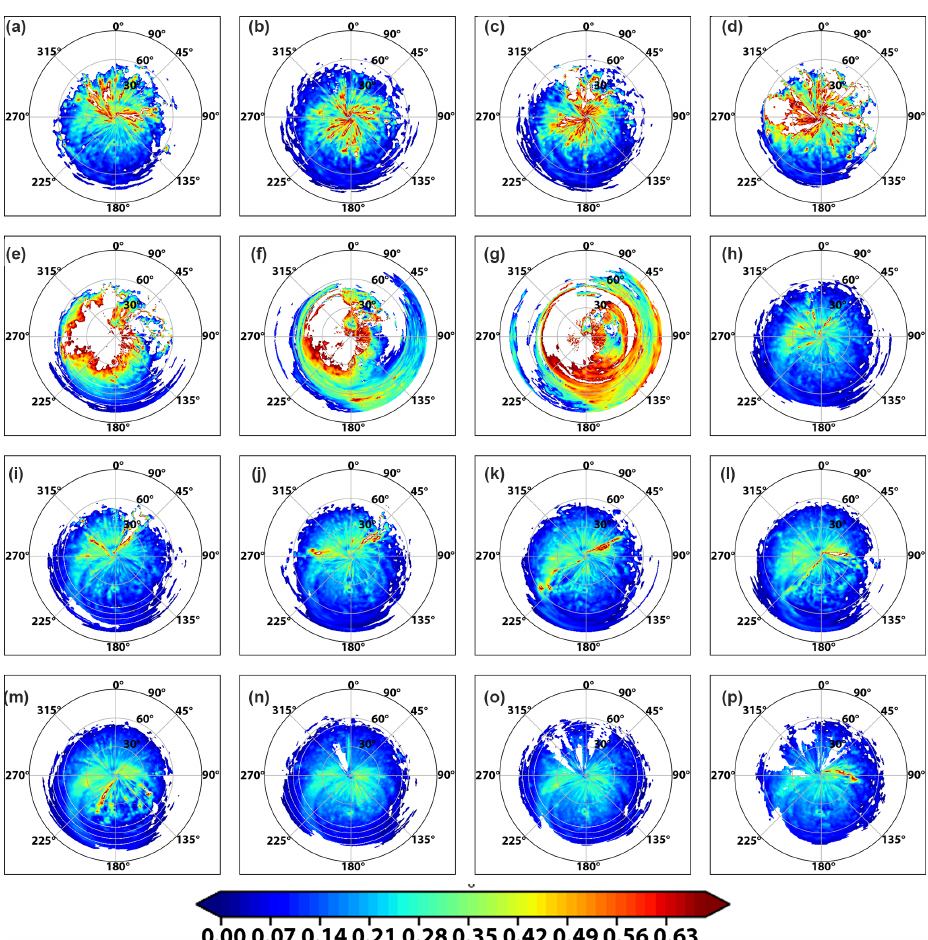
Figure 9. Retrieved aerosol optical depth ( λ = 0.500µm) above clouds and below the aircraft (AOD_cloudtop). Note that the actual retrievals are performed at 470 and 860nm assuming an extinction Ångström exponent of 1.77 (see also Table 2). Pixels without valid retrievals are shaded